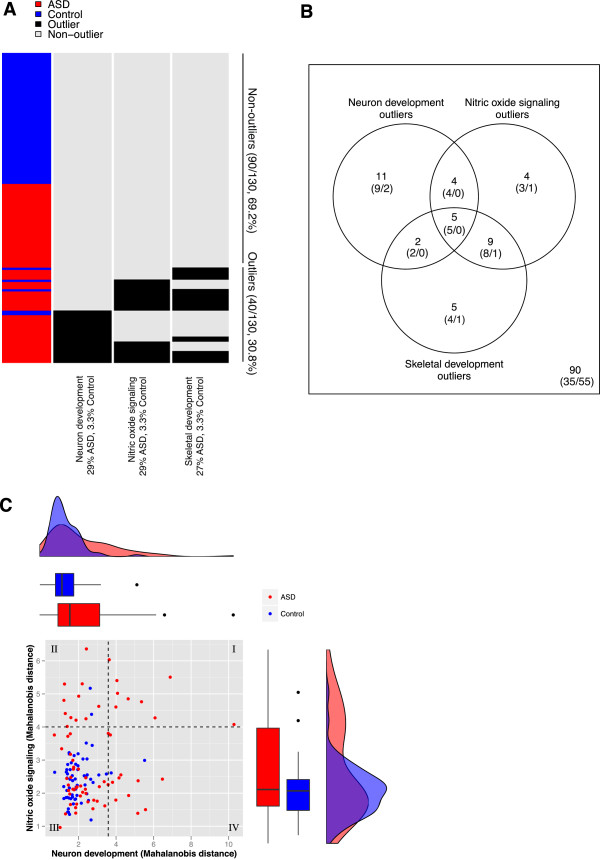
Outlier-enriched pathways in the TGen data set. A) Heatmap marking outliers for each outlier-enriched pathway: neuron development, nitric oxide (NO) signaling, and skeletal development (Figure 4, step 4). Samples sorted by outlier status followed by diagnosis. B) Venn diagram showing the overlap of outlier samples for the three pathways in Figure 1A. The numbers of case and control outliers, respectively, are shown in parentheses. C) A comparison of Mahalanobis distance values (Figure 4, step 2) in neuron development and NO signaling. Marginal density plots show the distributions of case (red) and control (blue) samples.